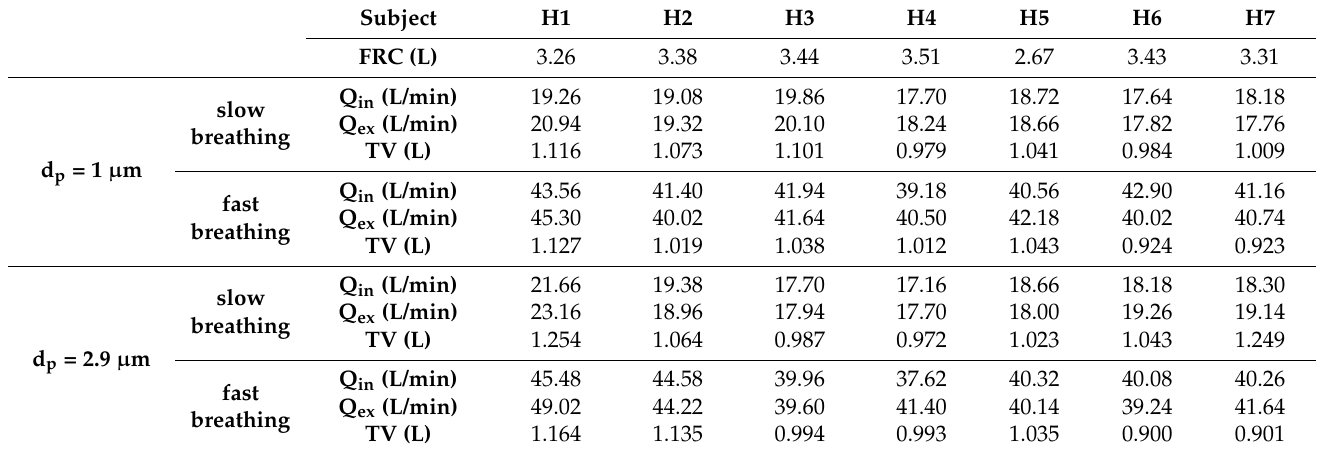
Table 2. Patient-specific flow rates in healthy